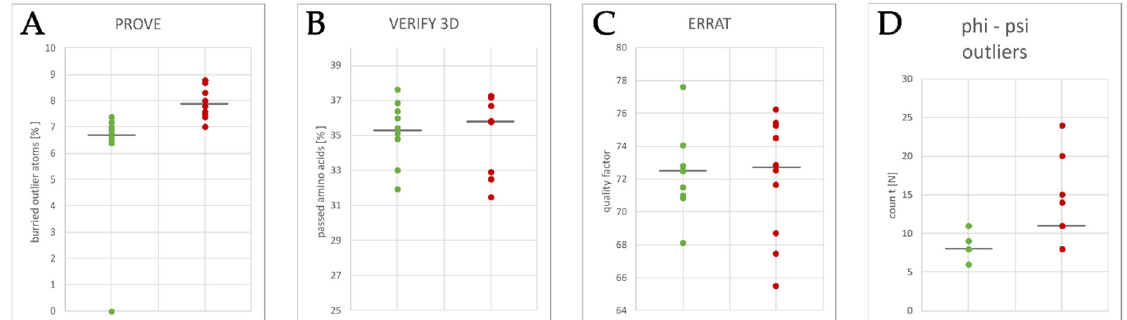
Figure 3. Geometric errors report for the 10 best (green dots) and 10 worst (red dots) homology models generated by the model evaluation software (as indicated). Significant differences were observed only in the PROVE calculation of the buried outlier atoms. Model evaluation was done using software ( A ) PROVE to calculate the buried outlier atoms, ( B ) VERIFY 3D to evaluate secondary structure of the model, ( C ) ERRAT to verify model structure based on the statistics of non-bonded atom-atom interactions and, ( D ) PROCHECK to calculate geometry of amino acids to find phi-psi outliers.